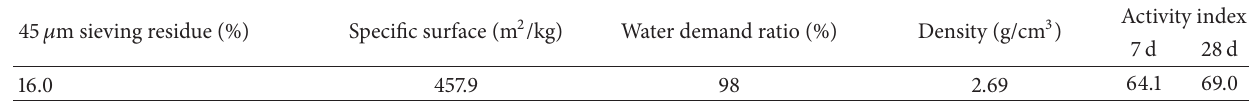
Table 2: Physical properties of limestone powder.